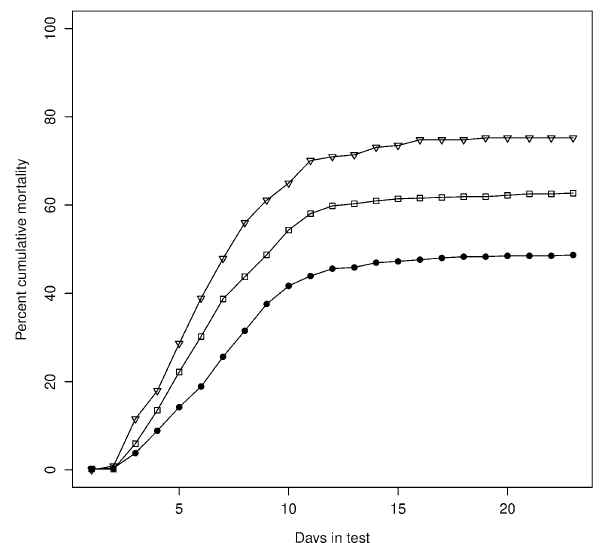
Figure 2. Percent cumulative mortality plotted over days in challenge test for G 1 animals in the high—(closed circles), random—(open squares) and low—(open triangles) gEBV groups. The total number of animals evaluated in the challenge test was 1883 (high 1027, random 622 and low